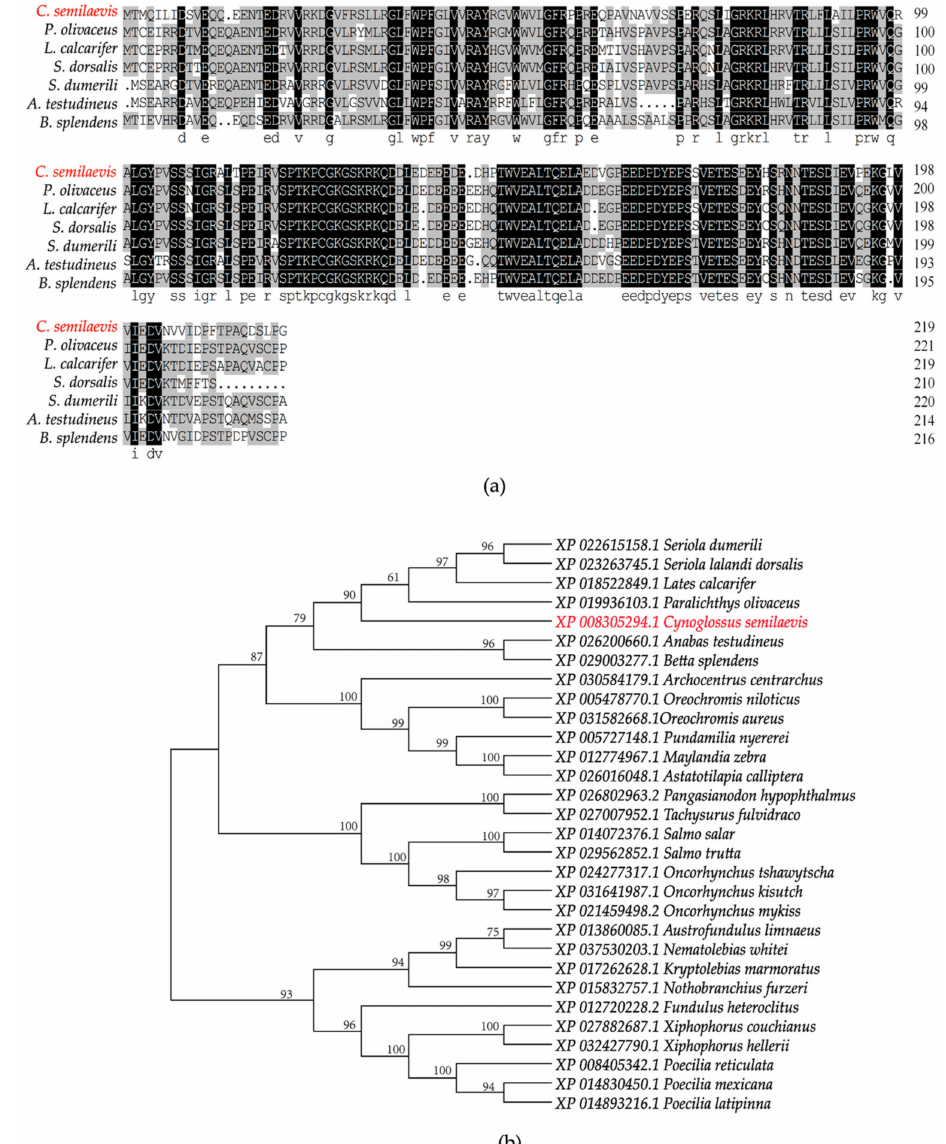
Figure 2. Homology analysis and phylogenetic tree of ORG proteins in bony fish. ( a ) DNAMAN was used to perform multisequence alignment of org amino acid sequences. Black boxes indicate sequence identity between amino acid sequences, while gray boxes indicate more than 75% simi- larity between amino acid sequences. Note: S. dumerili (Sequence ID: XP_022615158.1), L. calcarifer (Sequence ID: XP_018522849.1), S. dorsalis (Sequence ID: XP_023263745.1), P. olivaceus (Sequence ID: XP_019936103.1), A. testudineus (Sequence ID: XP_026200660.1), and B. splendens (Sequence ID: XP_029003277.1); ( b ) Phylogenetic tree based on the org amino acid sequence, using the neighbor- joining method. The number displayed on the branch node represents the guiding value (%). The C. semilaevis org is marked in red